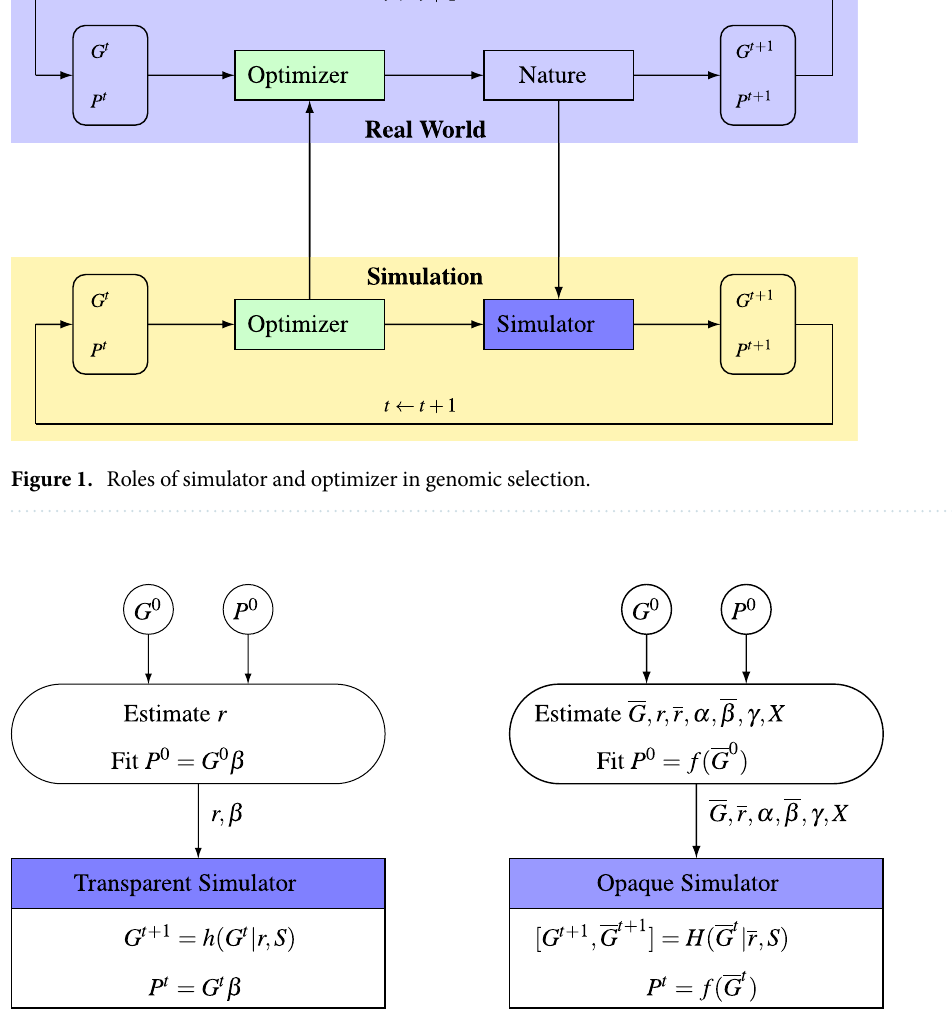
Figure 2. Designs of transparent (left) and opaque (right)